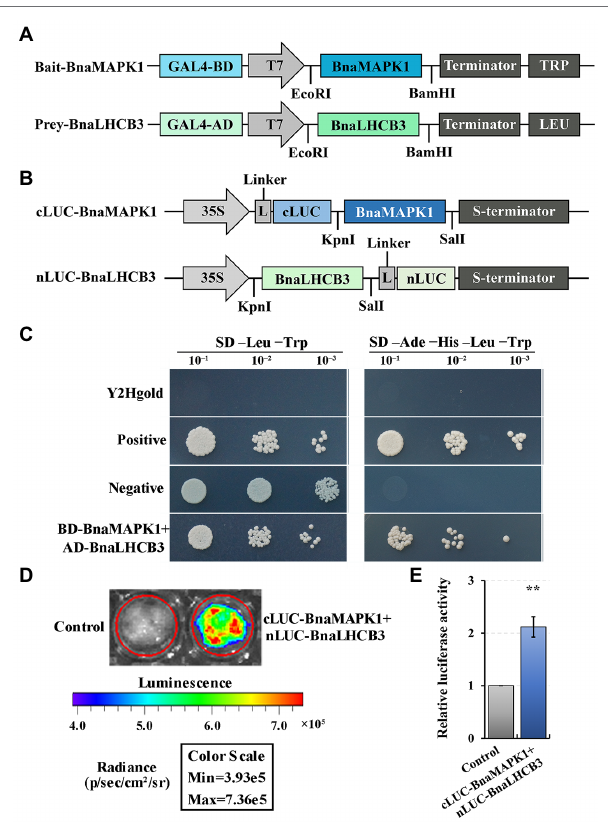
FIGURE 6 | Verifying the interaction relationship of BnaMAPK1 with BnaLHCB3. (A) Schematic diagram of the expression vectors used in Y2H assay. (B) Schematic diagram of the expression vectors used in Split-LUC assay. (C) BnaMAPK1 interacted with BnaLHCB3 in Y2H assay. Y2Hgold cells served as blank controls, Y2Hgold cells expressing pGBKT7-53 and pGADT7-T served as positive controls, and Y2Hgold cells expressing pGBKT7-Lam and pGADT7-T served as negative controls. (D) BnaMAPK1 interacted with BnaLHCB3 in Split-LUC assay. Empty pCAMBIA1300-nLUC and pCAMBIA1300-cLUC were used as controls for normalization. (E) Relative luciferase activities assays for determining whether BnaMAPK1 could interact with BnaLHCB3 in tobacco leaves. All the experiments were repeated three times with similar results. Double asterisk above bars indicate significant difference at p-value <